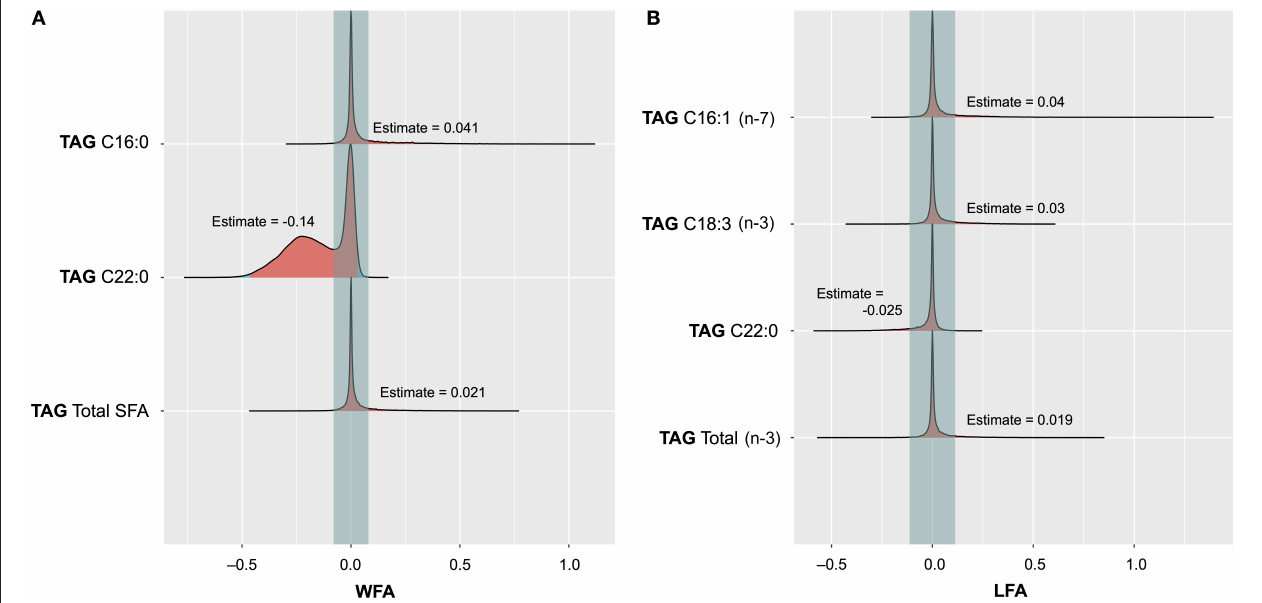
FIGURE 4 | Posterior distribution plots for the selected variables depicting the effect of FAs in triacylglycerols (TAG) in breast milk on the change of length for age (LFA) z -score (A) and weight for age (WFA) z -score (B) at the end of the follow-up period (12 months) with respect to